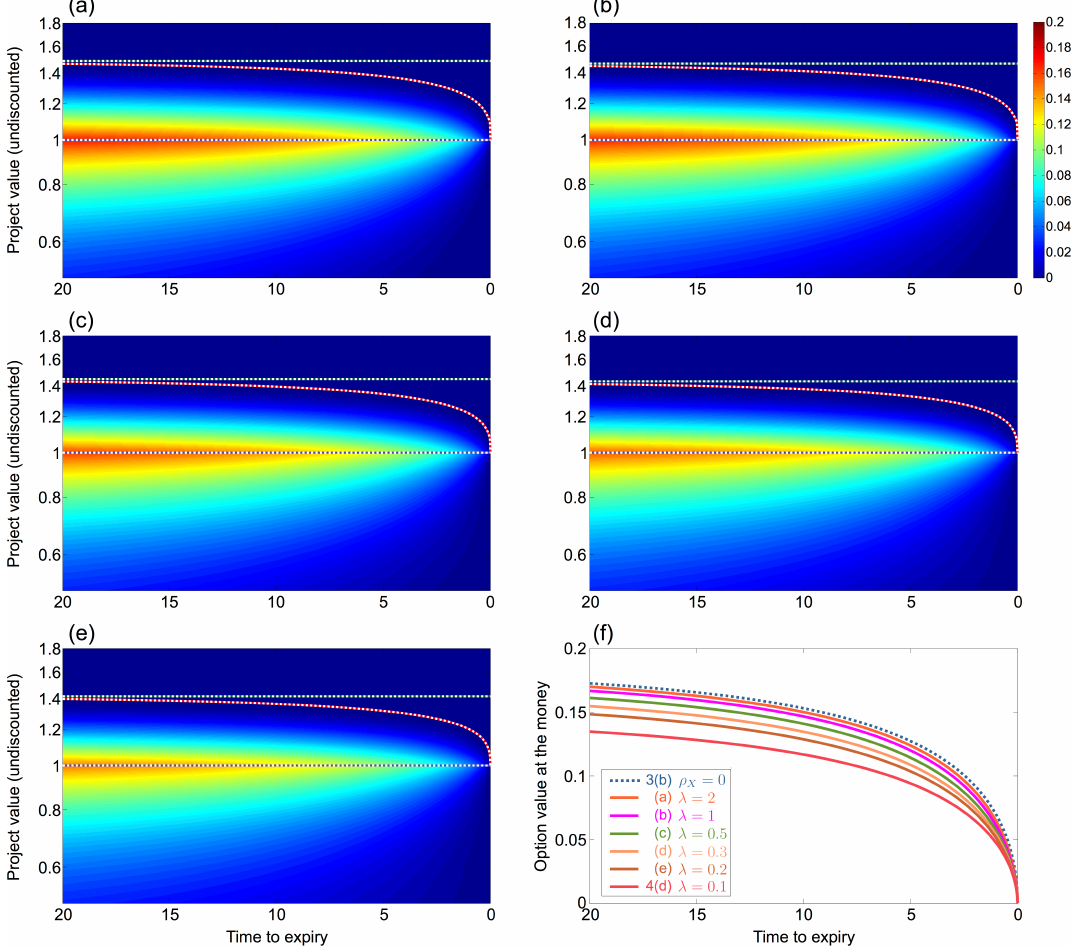
Figure 5. As in Figure 4d, but with jump rates λ equal to: ( a ) 2; ( b ) 1; ( c ) 0.5; ( d ) 0.3; ( e ) 0.2. ( f ) Plot of undiscounted option valuen at the money, versus time to expiry, for the five cases represented in ( a – e ). Exercise threshold at t = 0: ( a ) 1.4664; ( b ) 1.4481; ( c ) 1.4272; ( d ) 1.4075; ( e ) 1.3902. Option value at the money ( t = 0): ( a ) 0.1700; ( b ) 0.1668 ( c ) 0.1613; ( d ) 0.1548; ( e ) 0.1484. Calculation times (backwards induction step): ( a ) 4.37 s (1.4 × ); ( b ) 4.52 s (1.4 × ) ; ( c ) 4.84 s (1.5 × ); ( d ) 5.06 s (1.6 × ); ( e ) 5.46 s (1.7 ×